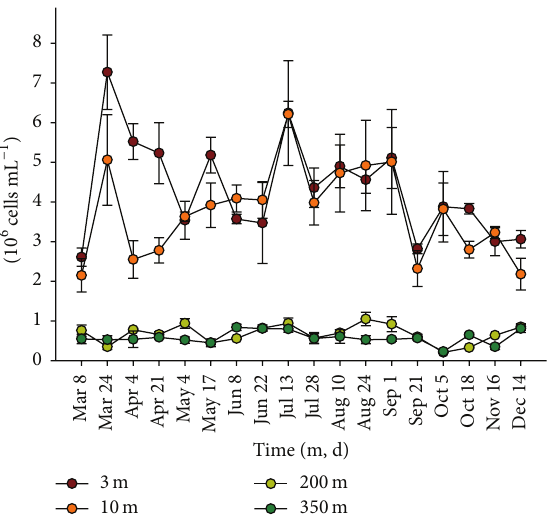
Figure 2: Total prokaryotic abundance ( ± s.d.) at 3, 10, 200, and 350 m depth at Ghiffa pelagic station, Lake Maggiore, in 2011 obtained from counts of DAPI stained